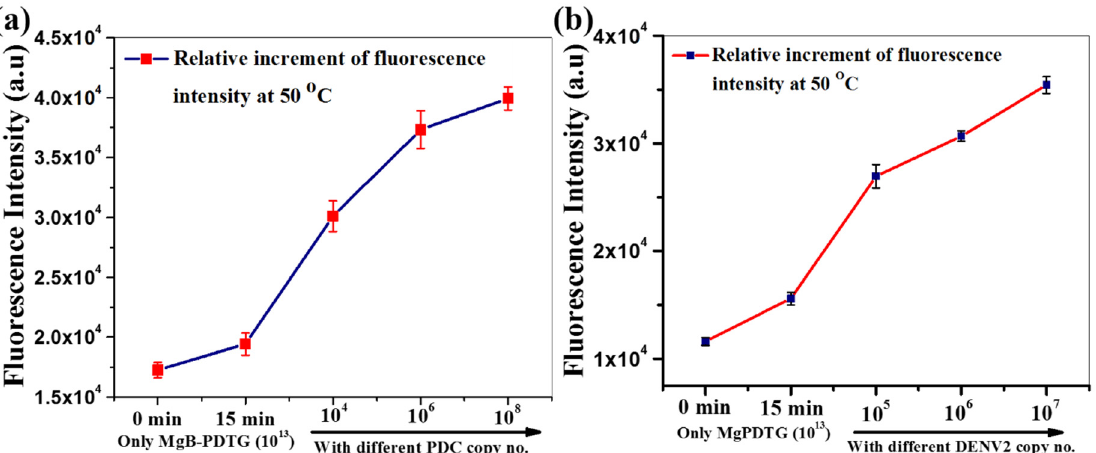
Figure 2. Evaluation of the sensitivity of the probes. ( a ) Relative fluorescence increment of only biotin-tagged, pan-dengue probe (PDTG) and PDTG with a different copy numbers of target PDC, ( b ) Strep-MagBeads, and biotinylated pan-dengue probe (Mg-PDTG) only, as well as in the presence of DENV1 target sequence at 50 °C. Each experiment was performed thrice ( n = 3), and error bars represent the standard deviation of fluorescence intensity measurement from average value.